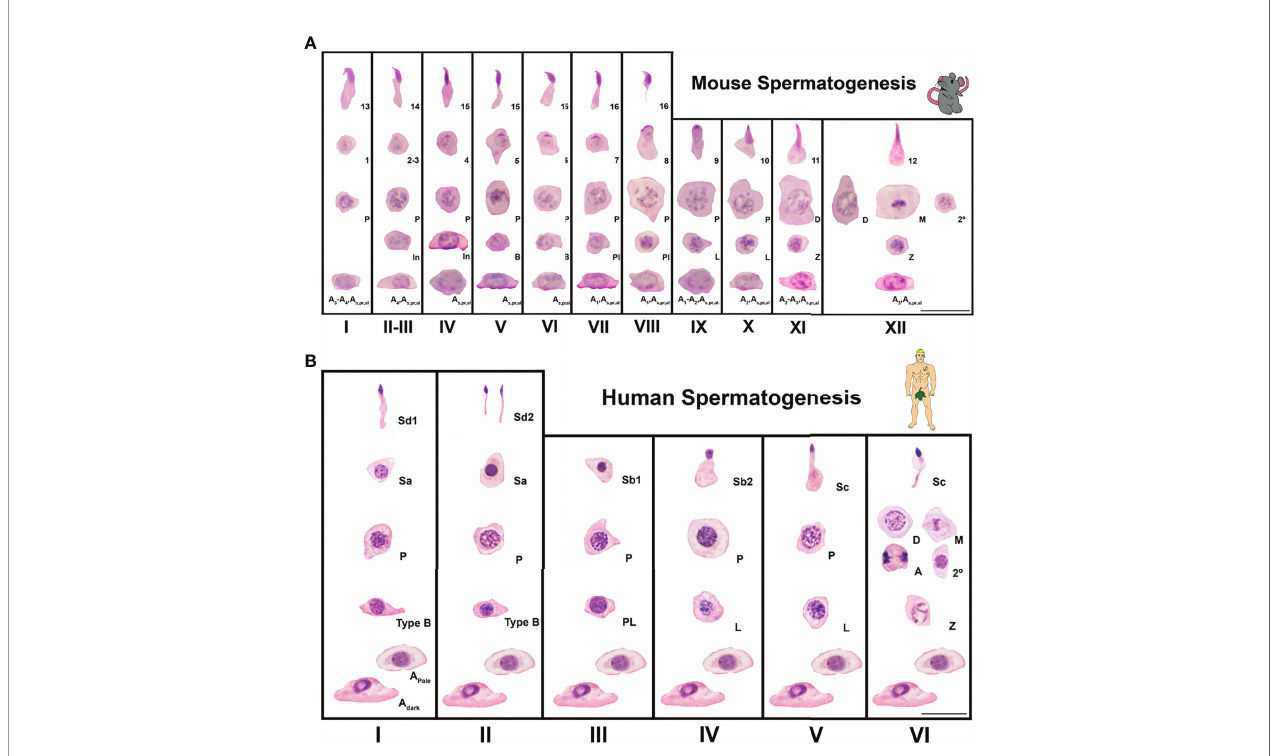
FIGURE 2 | Seminiferous epithelial stages of mouse and human spermatogenesis as classic spermatogenesis cycle staging charts using germ cell associations and morphology. Spermatogenesis is the process of sperm development and involves phases of mitosis, meiosis, and spermiogenesis (morphological cell changes). (A) Spermatogenesis in mice is a cycle that takes ~8.6 days (12 – 14). The time necessary for a germ cell to go from type A spermatogonia to spermatozoa (the complete process or duration of spermatogenesis) is about 35 days (12, 13, 15). In mice, spermatogenesis is divided into 12 stages (I-XII) and 16 spermatid developmental steps. A, In, and B are type A, intermediate, and type B spermatogonia, respectively. Pl, L, Z, P, D, M, and 2º are preleptotene, leptotene, zygotene, pachytene, diplotene, meiotic, and secondary spermatocytes, respectively. Steps of spermatid development are numbered 1-16. Sections were stained with Periodic Acid Schiff ’ s regent-hematoxylin (PAS-H), which is a conventional staining for staging of mouse testis sections. Scale is 20 m m. (B) . Spermatogenesis in men is a 16 day cycle with a complete duration that was classically determined to be 64 days but modern methods show to be closer to 74 days (16 – 21). In humans,